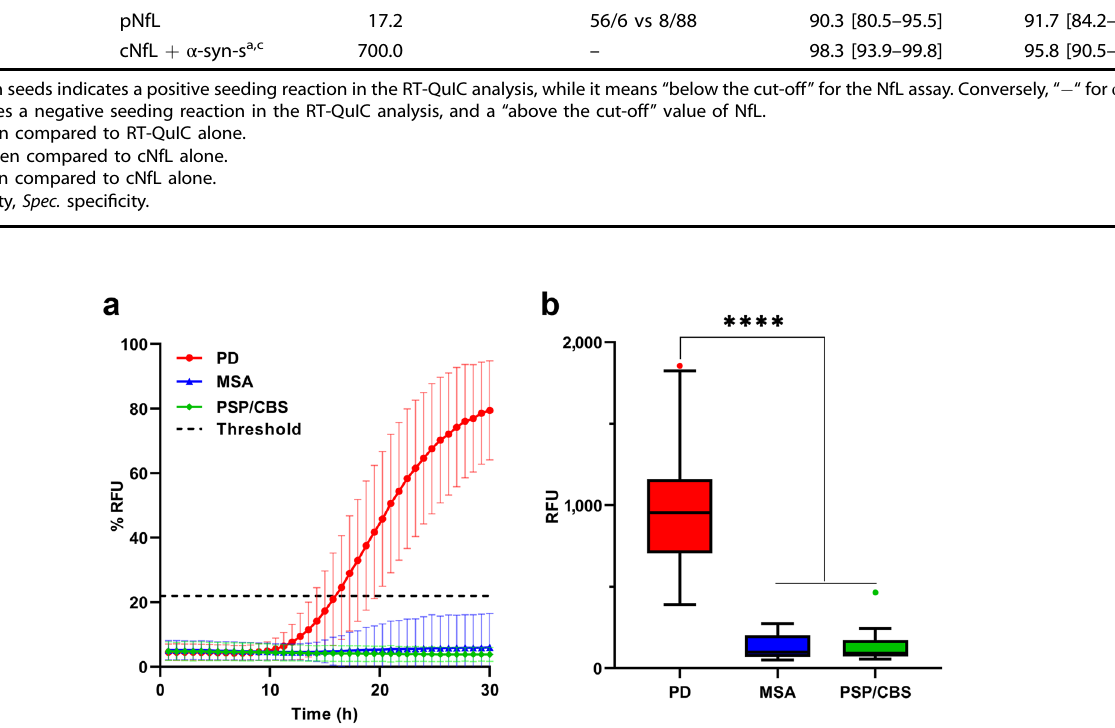
Fig. 2 Comparison of RT-QuIC seeding activity in PD and APDs. a Kinetic curves of PD patients with positive seeding activity compared to those of (all) patients from PSP/CBS, and MSA groups. Each curve represents the average of the group, error bars indicate the SD. b The area under the curve was chosen as the most representative parameter describing the kinetics of α -syn aggregation in the RT-QuIC assay. Bounds of box plots show the area under the curve range from the 25th to the 75th percentiles and the central line indicate the median value of the distribution; whiskers identify the Tukey ’ s range and symbols indicate the outliers according to the Tukey